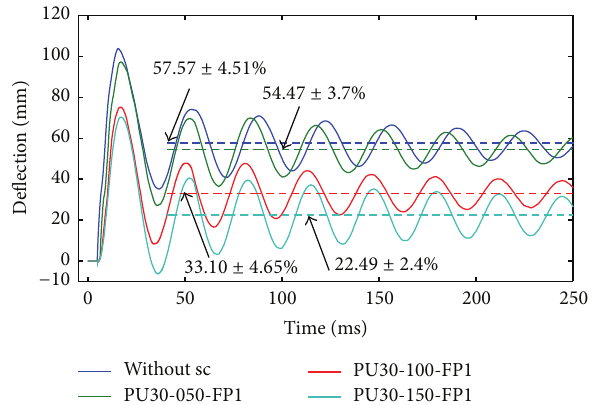
Figure11:ThemidspandeflectionofPU30-050-FP1,PU30-100-FP1, and PU30-150-FP1.